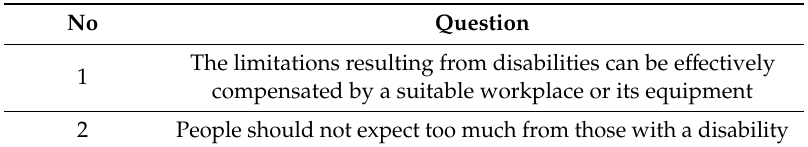
Table A2. Questionnaire items used to define Ambassador’s attitude [18,25].